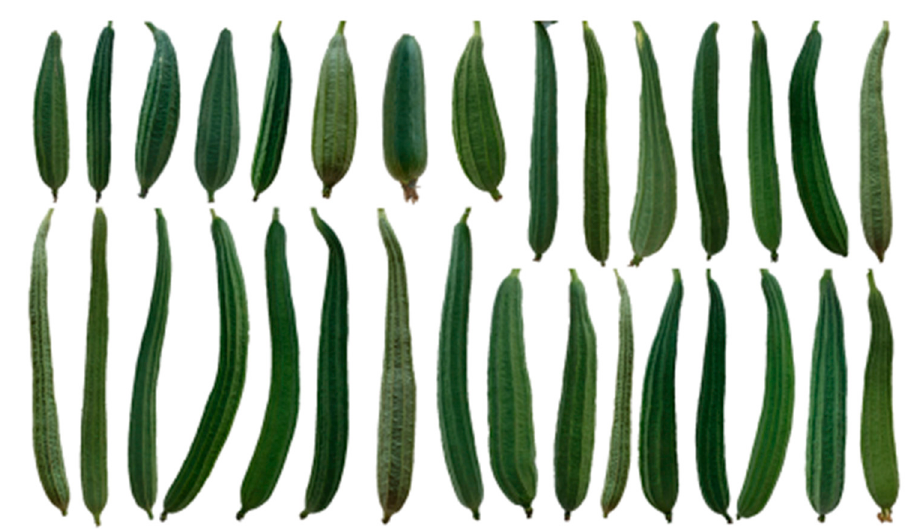
Figure 3. Fruit color and length variability among ridge gourd breeding lines developed at WorldVeg.